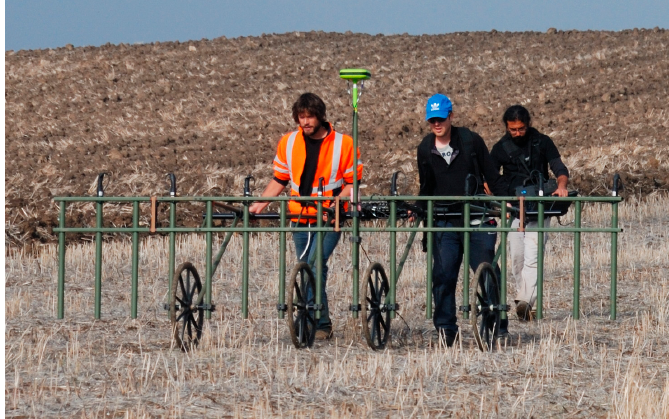
Figure 2. The SENSYS Sensorik and Systemtechnologie can carry up to 16 sensors, offering variations for sensor numbers and separations. The IGEAN setup included eight sensors with 50 cm separation. A high-precision Global Navigation Satellite System (GNSS) receiver helps in navigation and sensor-data registration.